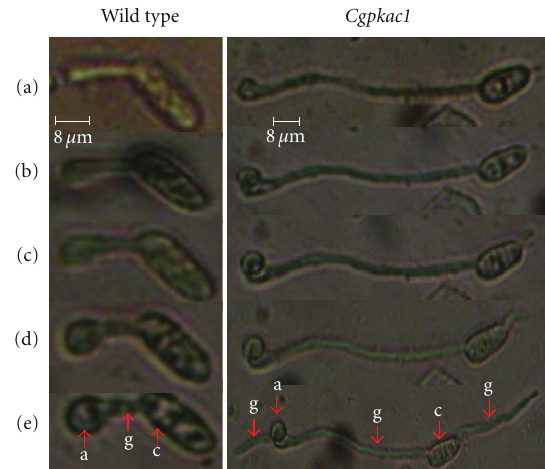
Figure 5: Progressive phases of C. gloeosporioides mutant Cgpkac1 and wild-type strain during conidial germination and appressorium formation. The image was captured using an Olympus phase contrast microscope (400x magnification) and a Nikon digital camera. Appressorium formation of 4-hour-old germlings on hydrophobic glass slide coated with rubber wax was observed at (a) 0 min; (b) 30 min; (c) 60 min; (d) 90min; (e) 180 min. (a: appressorium; c: conidium; g: germ